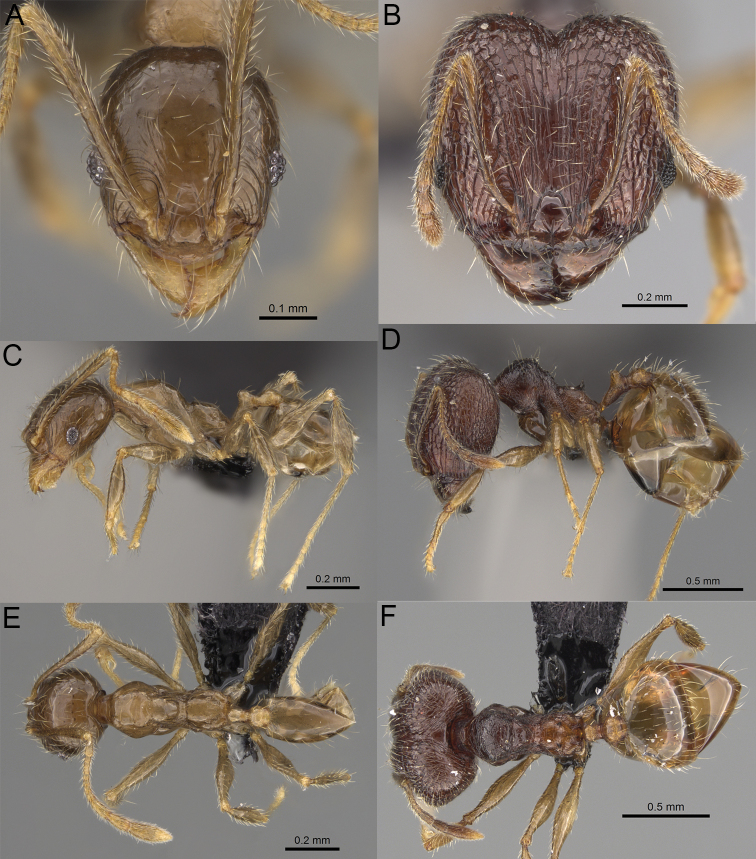
Pheidole
lavasoa sp. nov., full-face view (A), profile (C), and dorsal view (E) of paratype minor worker (CASENT0923282) and full-face view (B), profile (D), and dorsal view (F) of holotype major worker (CASENT0122898).